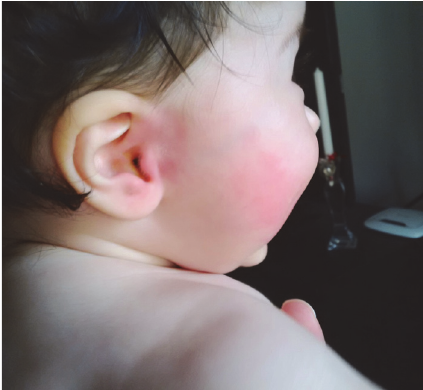
Figure 1: Erythema on the right cheek on eating citrus fruit.